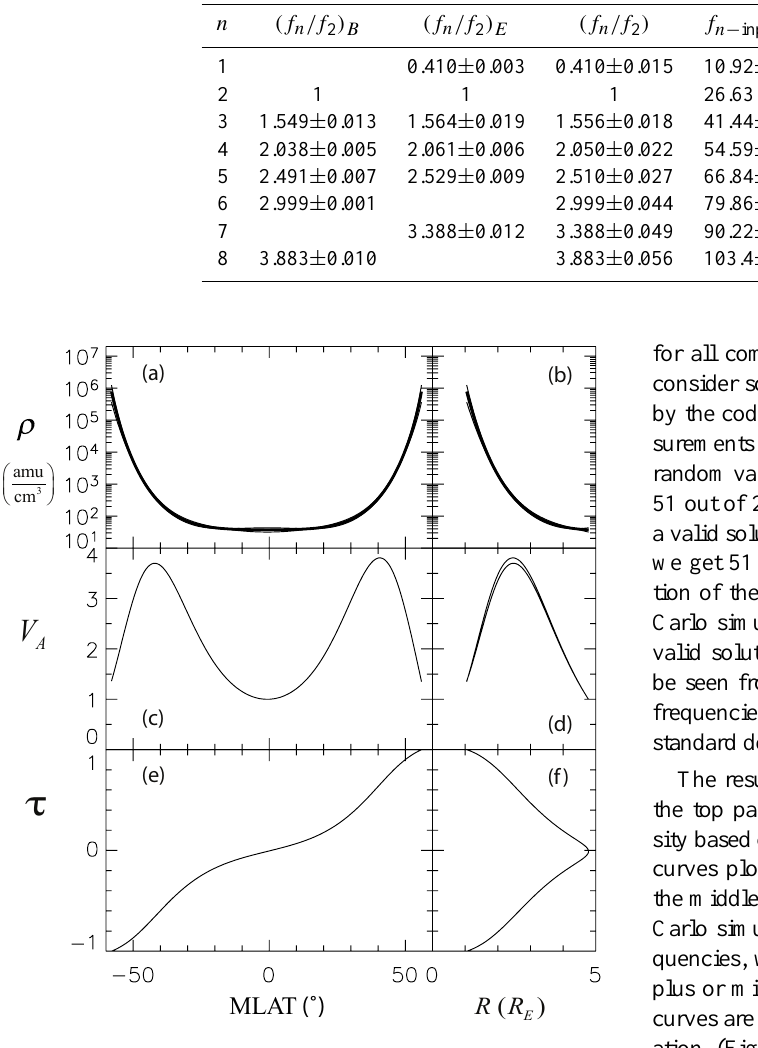
Fig. 5. (Top) Mass density ρ , (middle) Alfv´en speed V A normal- ized to unity at the magnetic equator (MLAT=0), and (bottom) the Alfv´en crossing time coordinate τ versus MLAT (left) and geocen- tric radius R (right) based on solutions for ρ found from Alfv´en wave frequencies observed on 28 October